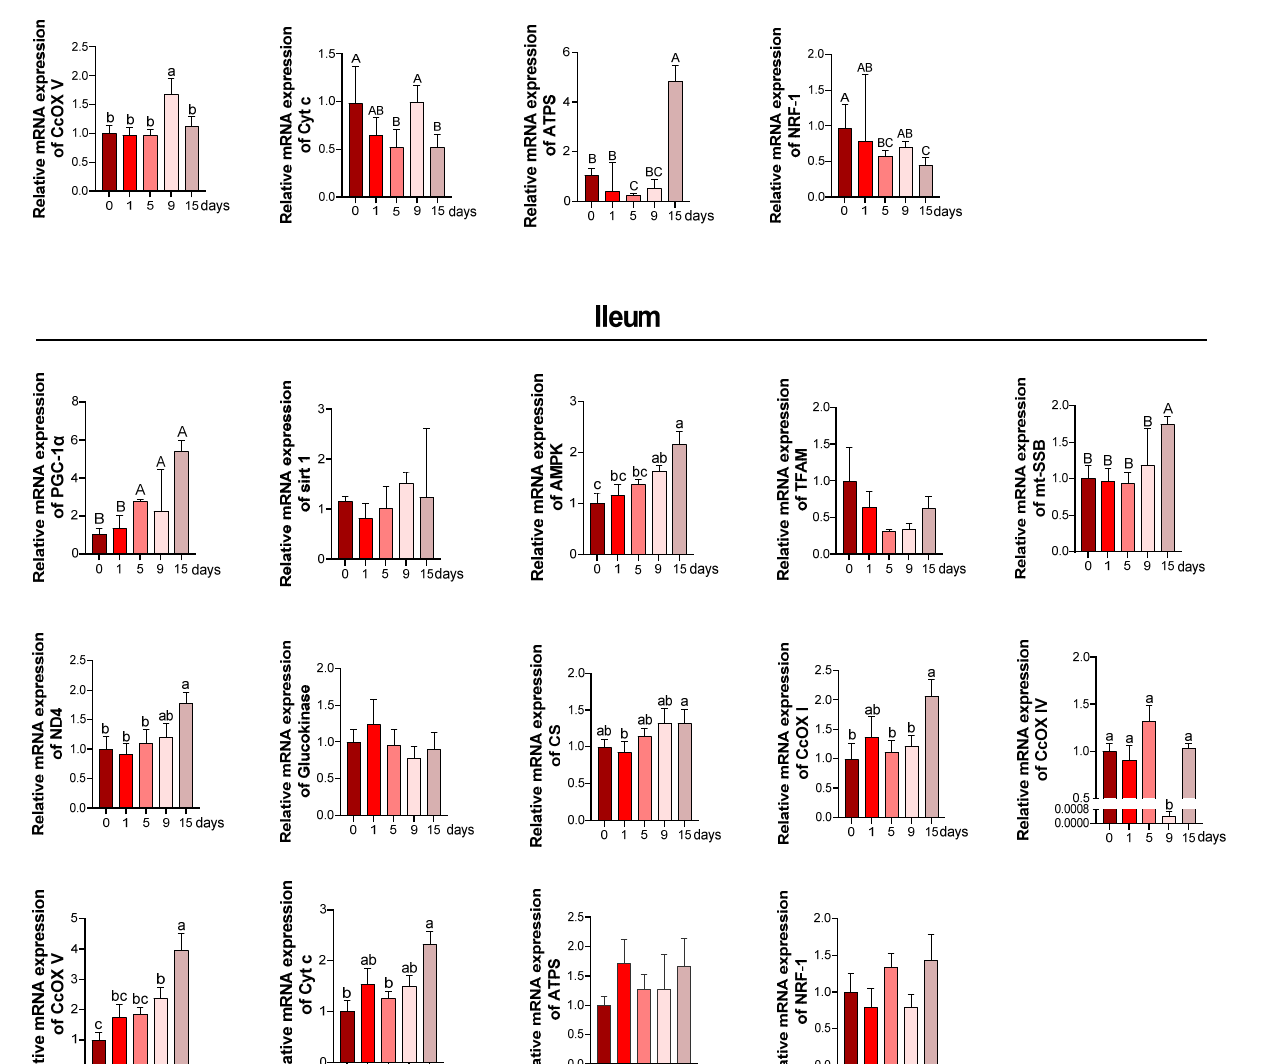
Figure 6. The mRNA expression of mitochondrial biogenesis and functions for related genes. n = 6 for each group. a,b,c Values within a row with different lowercase letters differ significantly ( p < 0.05) by the Duncan’s multiple comparisons. A,B,C Values within a row with different capital letters differ significantly ( p < 0.05) by the Kruskal–Wallis test. PGC-1 α , peroxisome proliferator-activated